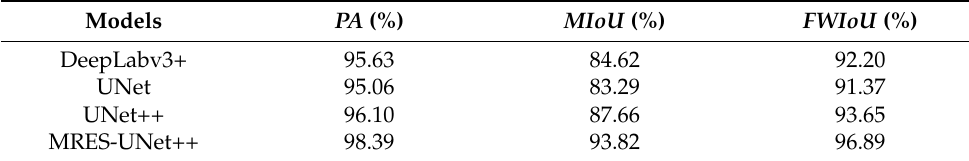
Table 1. The segmentation effect of four